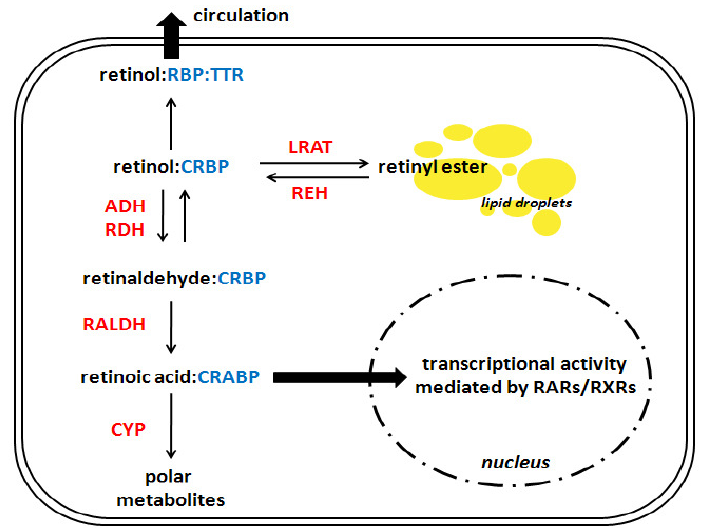
Figure 2. A simplified overview of retinoid metabolism in a hypothetical cell. This scheme reflects retinoid metabolism in a hypothetical cell. The reader should note that these processes do not typically occur within all cells in vivo , but have been grouped here for simplicity. Similarly, multiple isoforms exist for many of the binding proteins and enzymes presented below; for a complete review of retinoid metabolism, please refer to the recent review by D’Ambrosio et al . [55]. In the cytoplasm, retinol is bound to a cellular retinol- binding protein (CRBP), from this point there are three possible pathways for retinol to take. First, retinol can be transferred to retinol-binding protein (RBP), which itself is bound to transthyretin (TTR), and secreted into the circulation. Second, it can be esterified into retinyl ester by lecithin:retinol acyltransferase (LRAT), and stored in cytoplasmic lipid droplets. Third, it can be metabolized into retinaldehyde and subsequently converted into retinoic acid. Retinoic acid may be bound by a cellular retinoic acid binding protein (CRABP), which can direct it toward the nucleus where it can signal through the nuclear transcription factors retinoic acid receptor (RAR) and retinoid X receptor (RXR), or it can be directed toward catabolism into polar metabolites by various members of the cytochrome P450 family (CYP). Catalytic enzymes are shown in red text; binding proteins are in blue text. ADH: alcohol dehydrogenase; RALDH: retinaldehyde dehydrogenase; RDH: retinol dehydrogenase; REH: retinyl ester